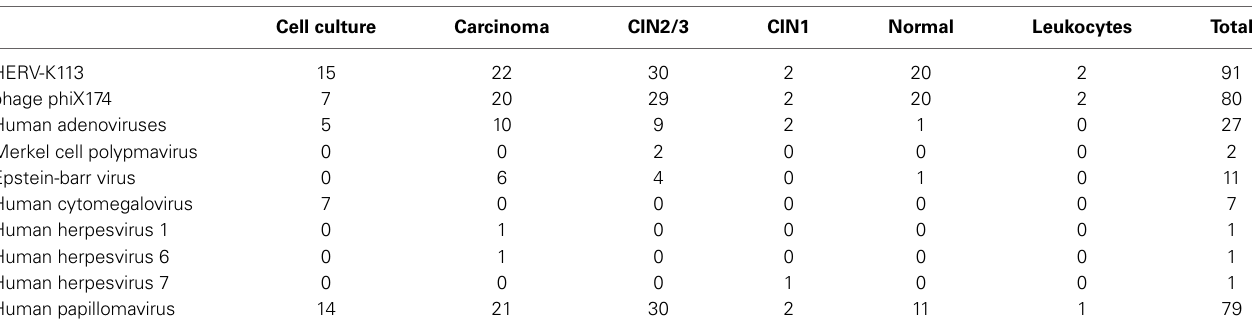
Table 2 | Sample counts ( N vs ) of relevant identified